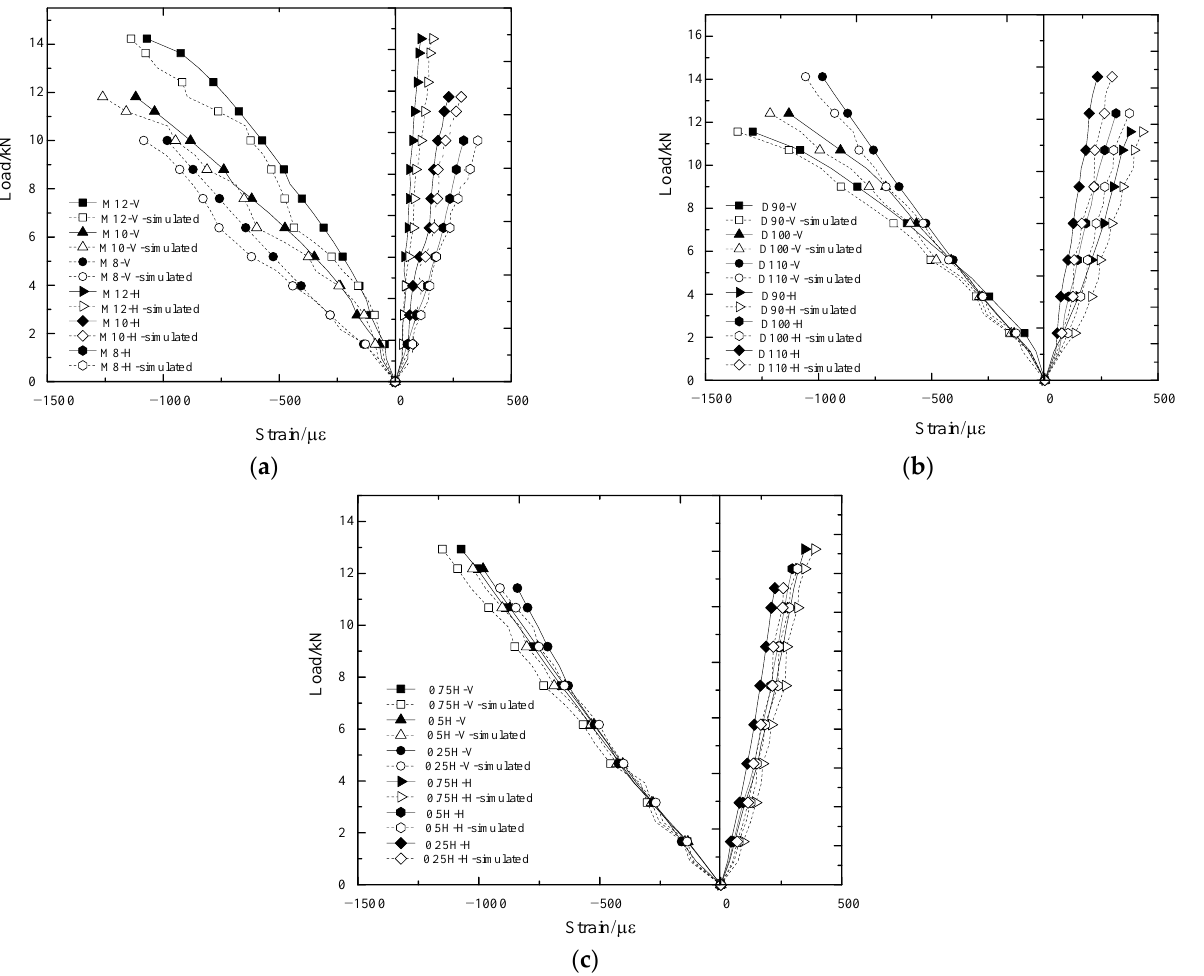
Figure 10. Comparison of simulated and test stress – displacement curves of composite joints. ( a ) Stress – displacement curves of D100-0.5H-M8; ( b ) Stress – displacement curves of D100-0.5H-M10; ( c ) Stress – displacement curves of D100-0.5H-M12; ( d ) Stress – displacement curves of D90-0.5H-M10; ( e ) Stress – displacement curves of D110-0.5H-M10; ( f ) Stress – displacement curves of D100-0.25H- M10; ( g ) Stress – displacement curves of D100-0.75H-M10.